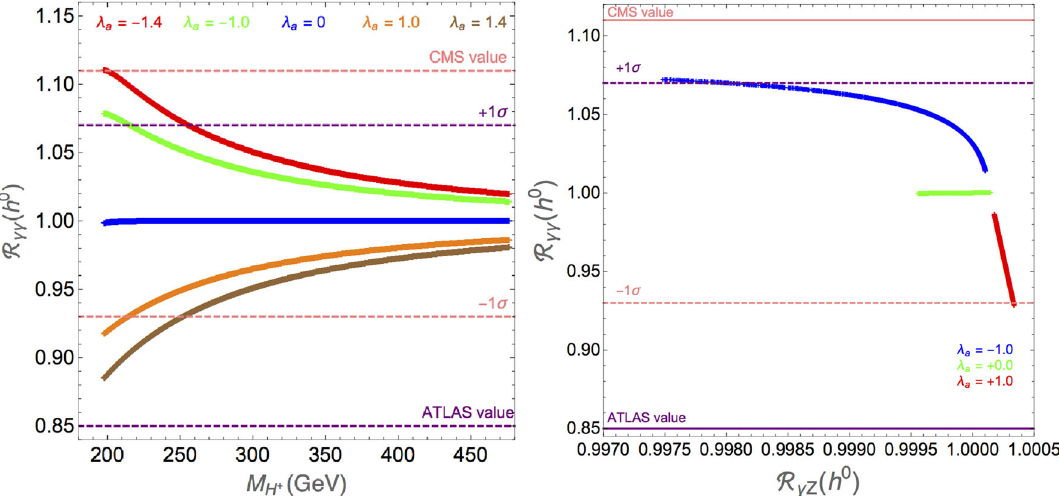
Fig. 5 R γγ ( h 0 ) as a function of m H ± for various values of λ a (left). Correlation between R γγ ( h 0 ) and R γ Z ( h 0 ) for various of λ a (right). We take as inputs: λ ≈ 0 . 52, 2 . 5 ≤ μ ≤ 15 (GeV) ( m h 0 ≈ 125 GeV), λ b = 1 and v t = 1